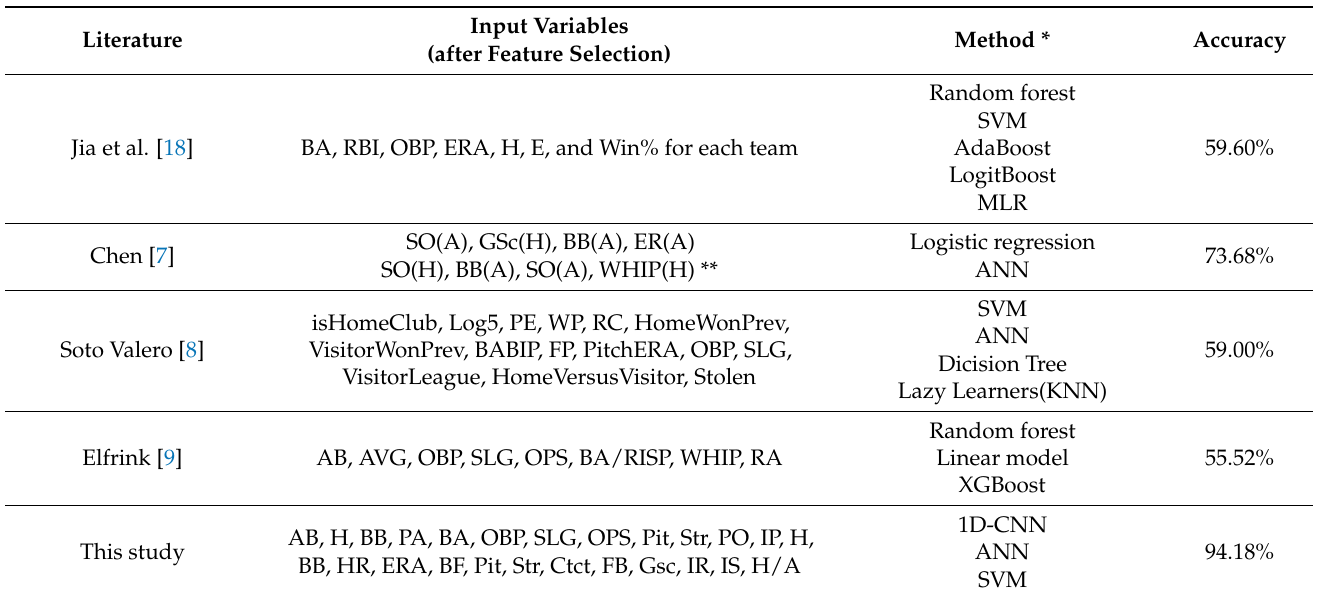
Table 17. Comparison of prediction models for MLB